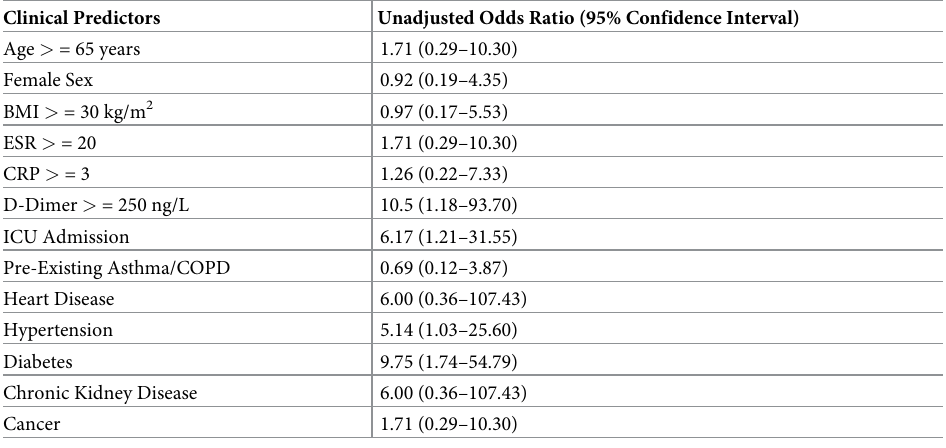
Table 2. Clinical factors associated with persistent COVID-19 related respiratory abnormalities at 6 months post-infection^, using univariate logistic regression analyses, n = 51. Clinical